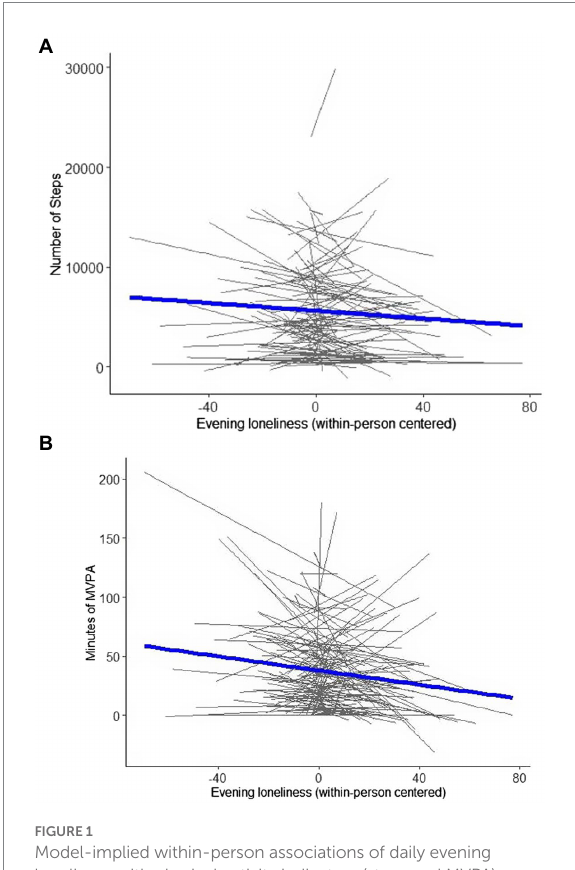
FIGURE 1 Model-implied within-person associations of daily evening loneliness with physical activity indicators (steps and MVPA). MVPA = moderate-to-vigorous physical activity. Number of steps (A) and moderate-to-vigorous physical activity (B) was higher when individuals felt less lonely than